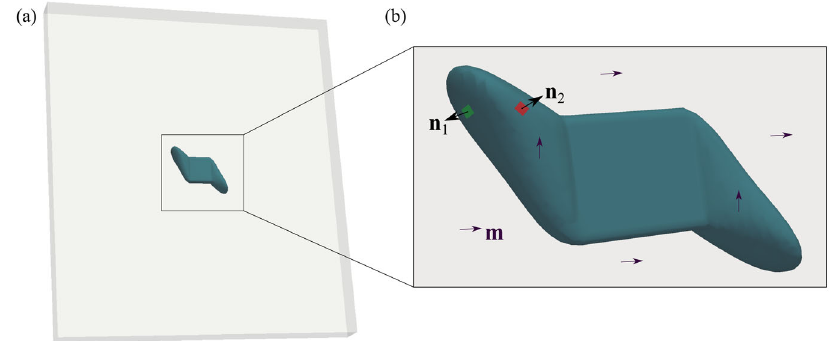
Fig. 5 A 3D visualization of the needle domain. a This needle domain forms around an embedded defect in our micromagnetic computations. b The inset fi gure shows the needle domain with distinct surfaces (marked by surface-normal vectors n 1 , n 2 ). The surface n 1 approximately satis fi es the strain-compatibility condition, however, the surface n 2 is not compatible and contributes to nonzero elastic energy in the system. The magnetization is denoted by m